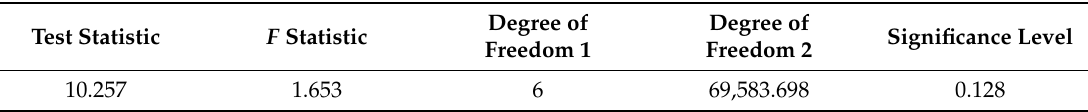
Table 4. The Box’s M test results.